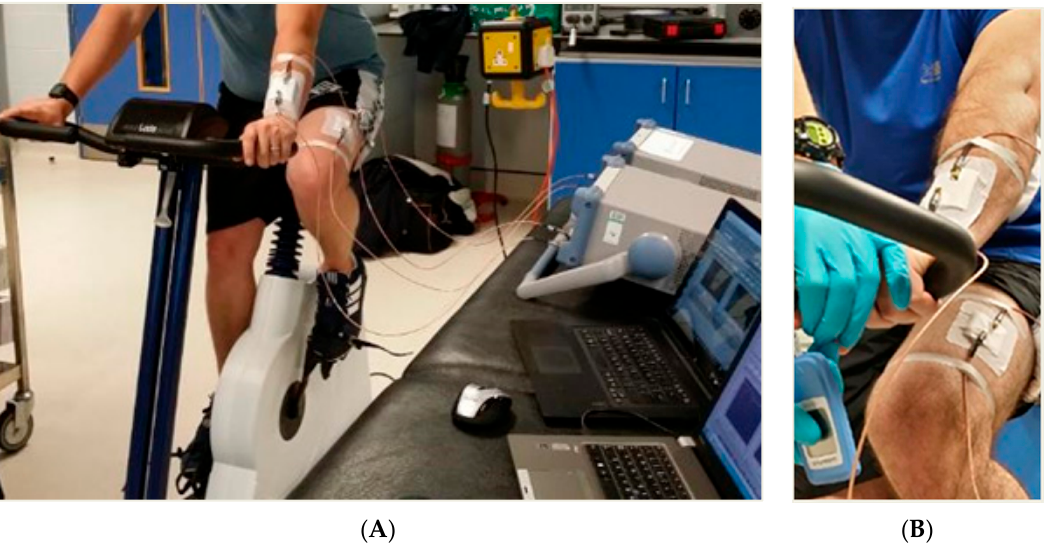
Figure 9. ( A ) Experimental setup, showing participant on ergometer with sensors attached; and appropriate data acquisition hardware: ( B ) illustrates placement of sensors both arm and leg during a blood lactate exercise protocol.